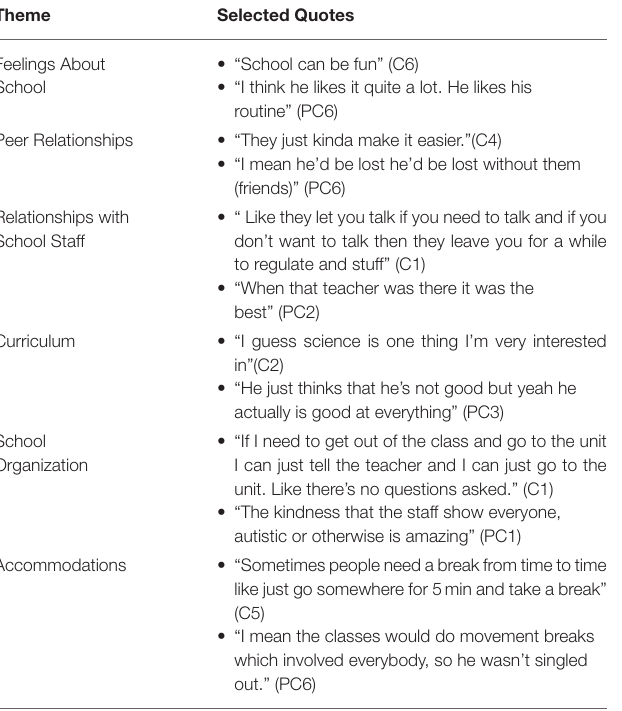
TABLE 2 | Fits pre-transition. TABLE 3 | Fits